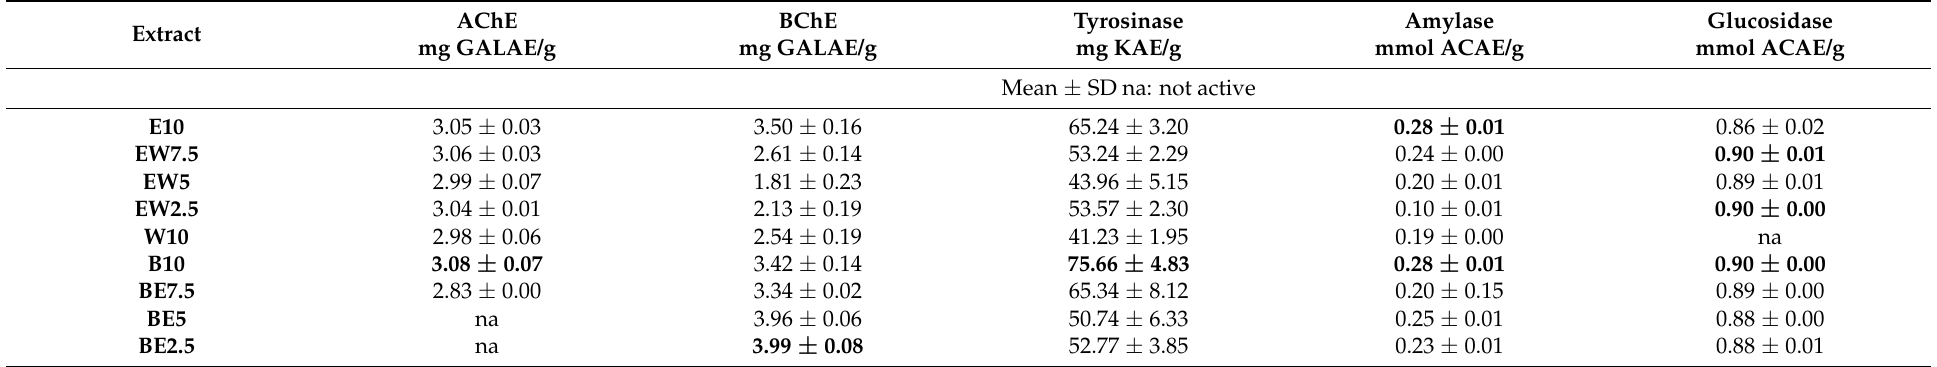
Table 10. Anti-enzymatic activity of Allium scorodoprasum flower